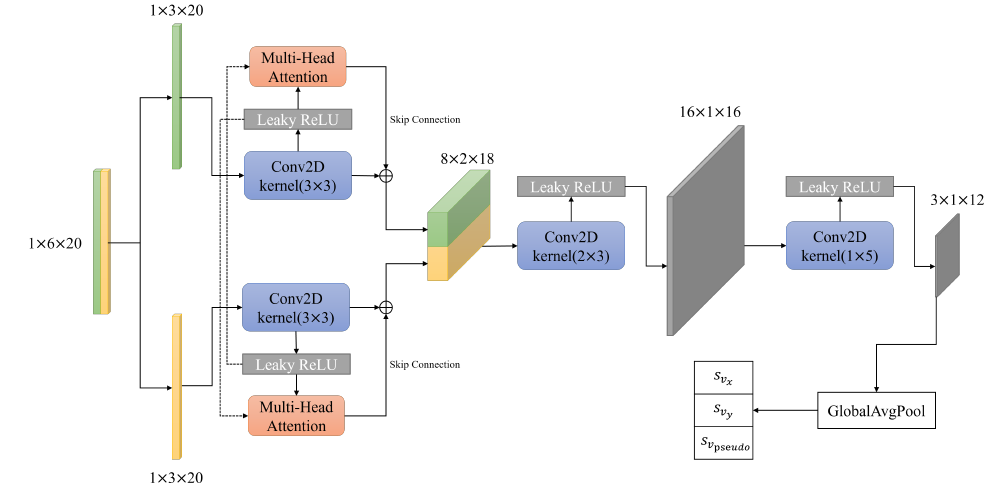
Figure 2. The proposed CNN architecture for predicting the parameters s v used to calculate the covariances as per Equations (25) and (26). The input consists of a window size of 20 IMU data points, each containing the acceleration and angular velocity data for all three